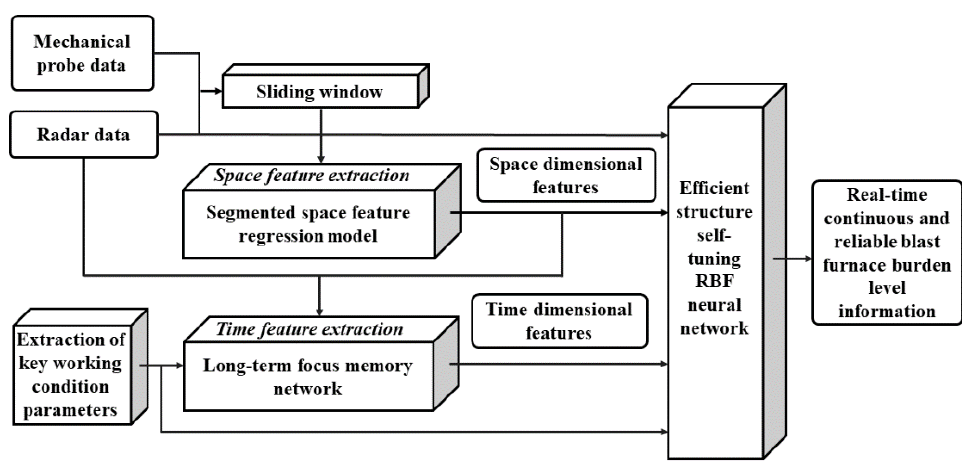
Figure 1. Research framework of the blast furnace burden level prediction and detection.